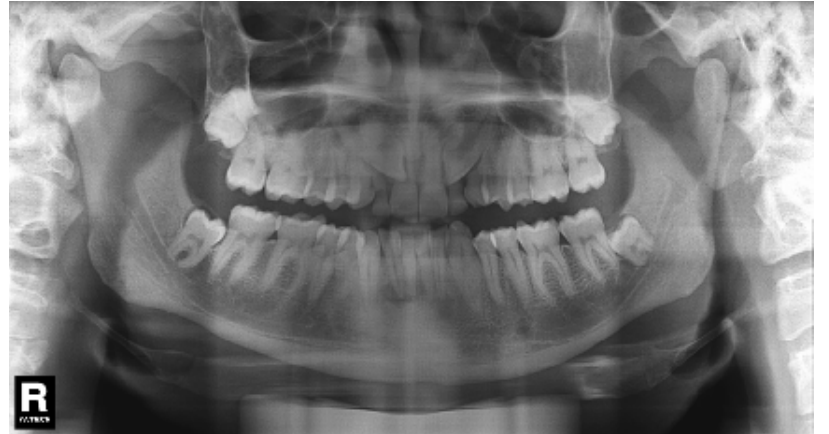
Figure 2: Panoramic Image Showing Bilateral Impacted Maxillary Canine RESULTS